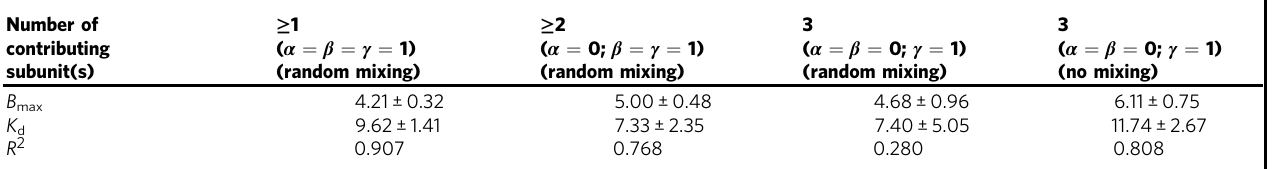
Table 1 Global fi t results for different gating models Number of contributing